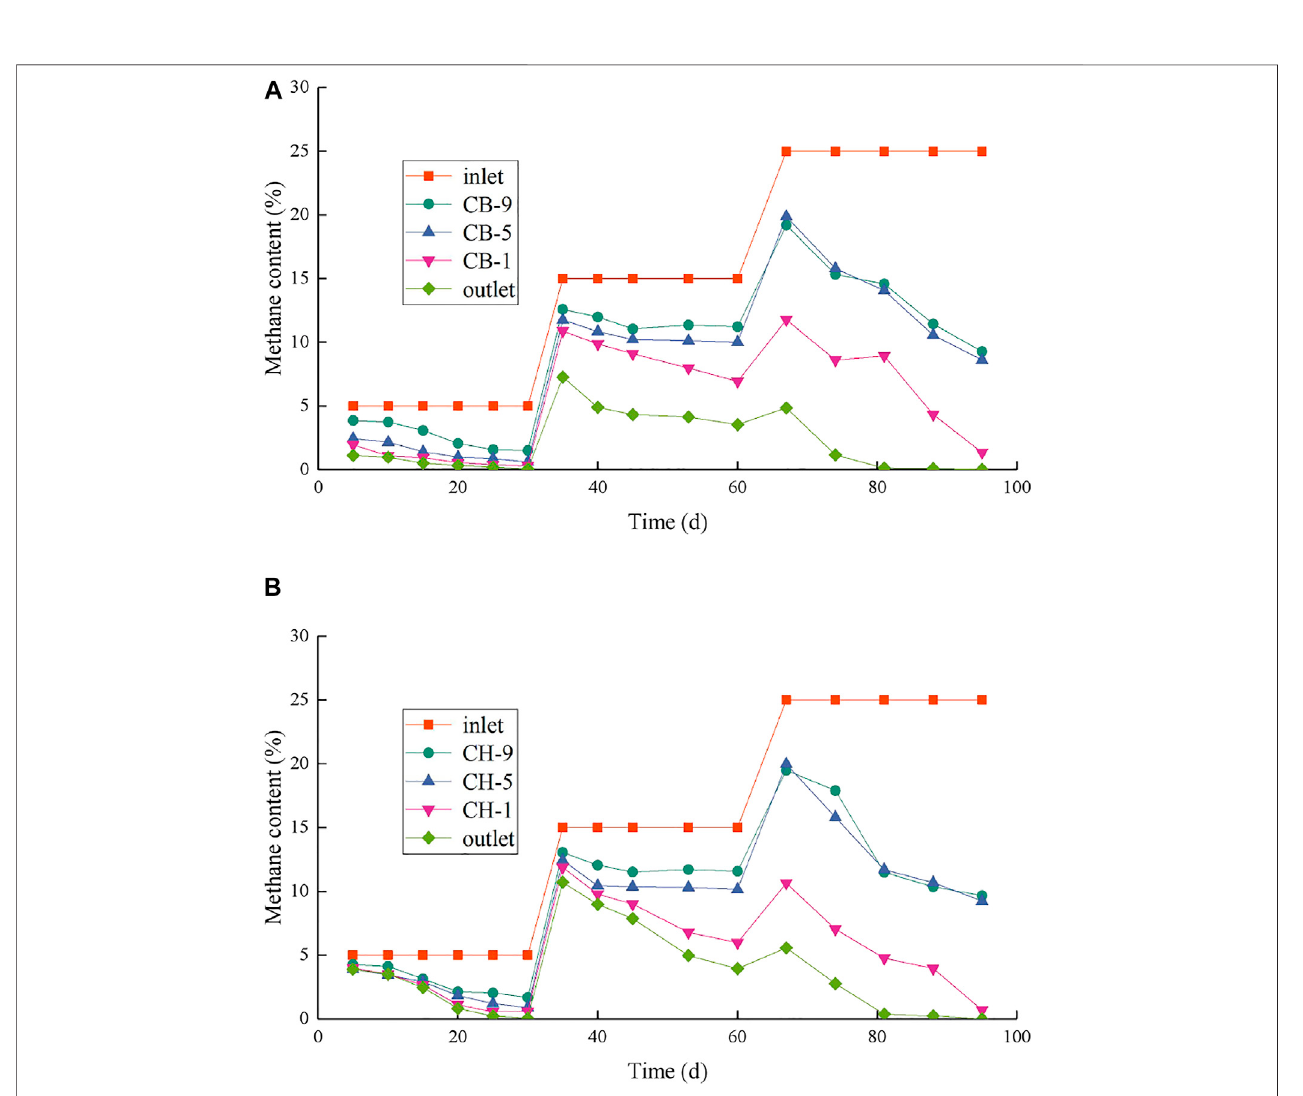
FIGURE 2 | Changes of CH 4 content in sampling ports of CB (A) and CH (B) at different stages.